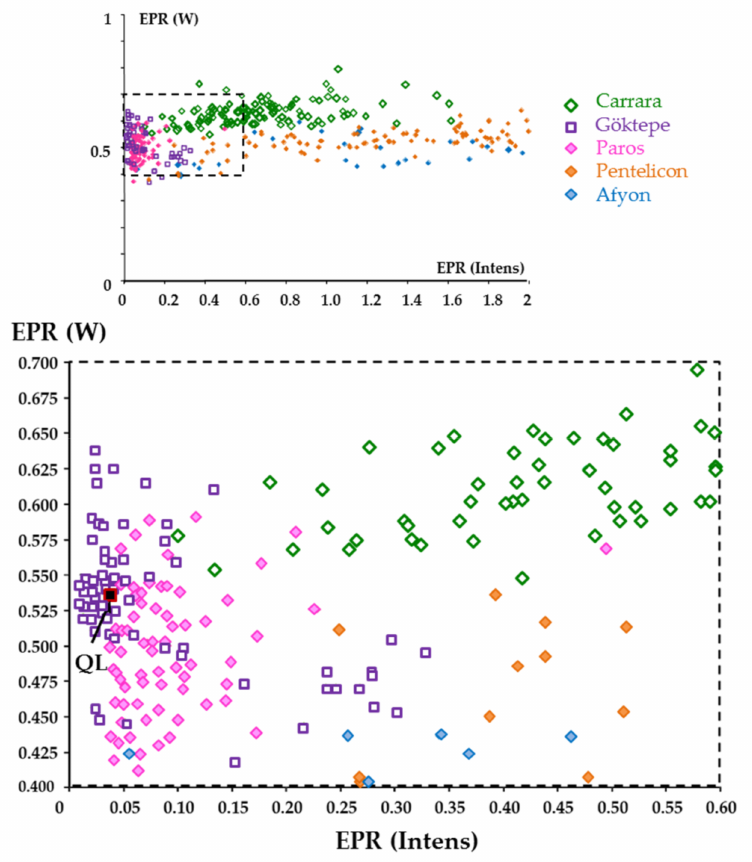
Figure 11. Scatterplot and close-up view (area with dashed line) of EPR parameters W versus Intens of the archaeological sample QL (red and black square) with data compiled from [14,30] for the most important fine-grained marble